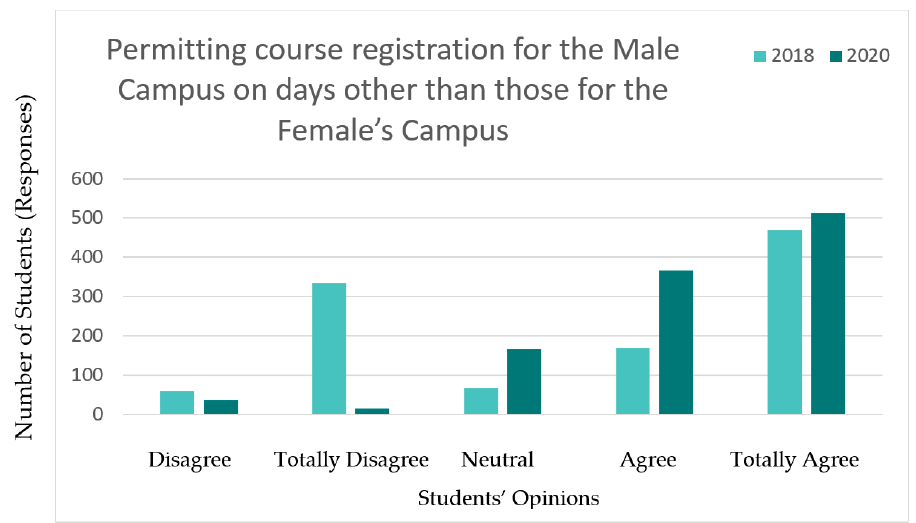
Figure 5. Distribution of student numbers according to their feedback on permitting course regis- tration for the male campus on days other than those reserved for the female campus in 2018